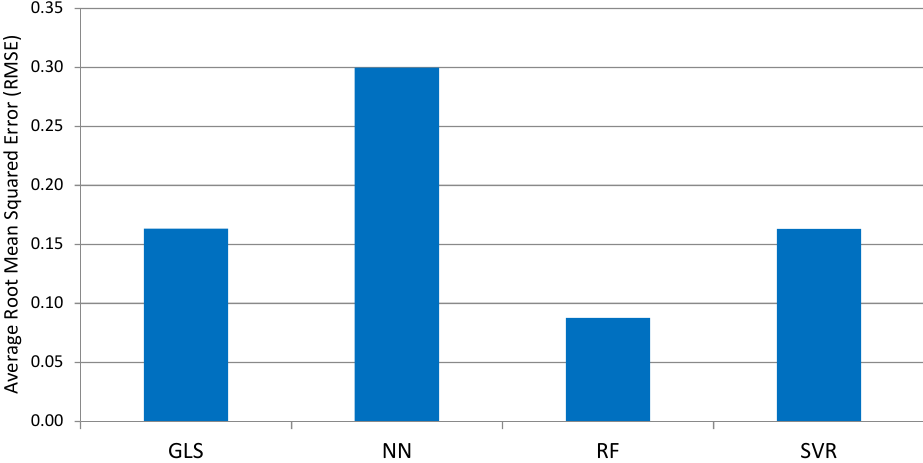
Figure 18. Comparison of average Root Mean Squared Error (RMSE) obtained from four machine- learning algorithms (on predicting MPI of 2017). Source: Calculation and graphics generated by au- thors.